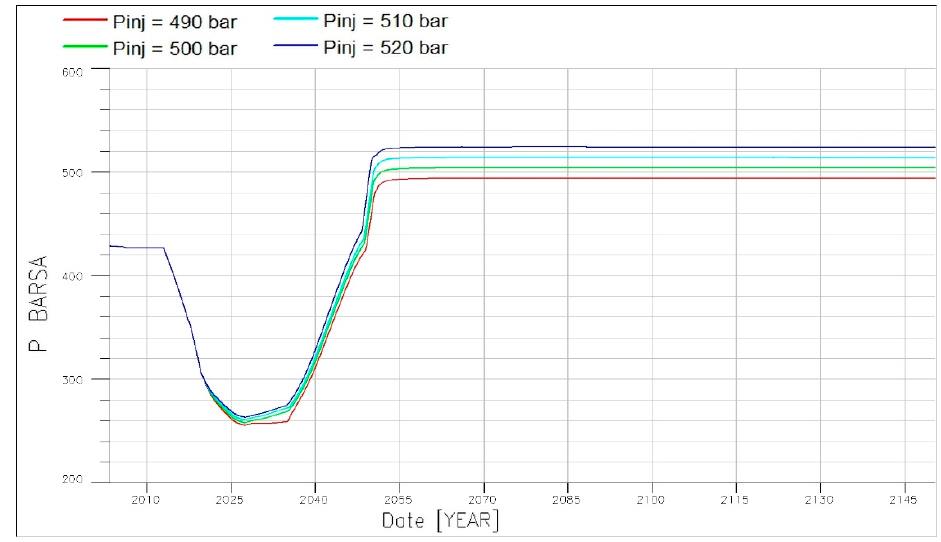
Figure 25. Average reservoir pressures for various injection scenarios. Figure 26. Total CO 2 leakage amounts to the reservoir caprock for various injection